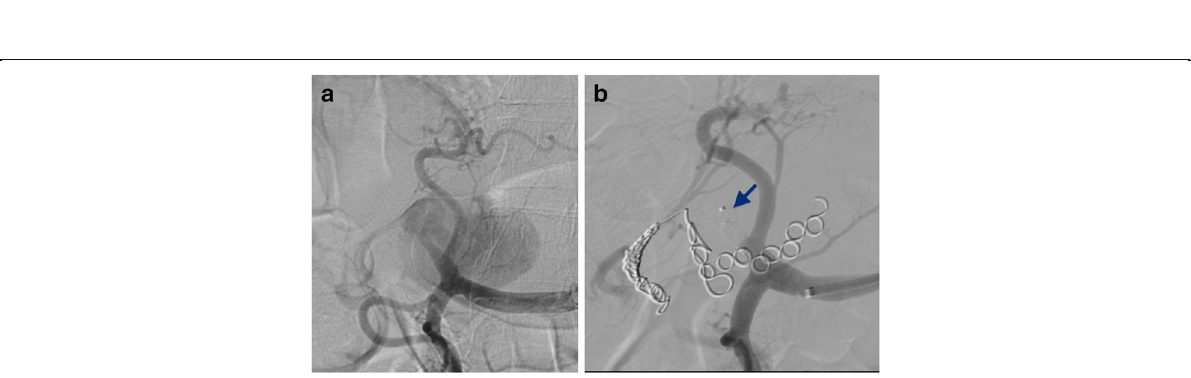
Fig. 3 a A huge aneurysm of the right hepatic artery. b A vascular plug (arrow), instead of a penumbra occlusion device, was placed in the proximal right hepatic